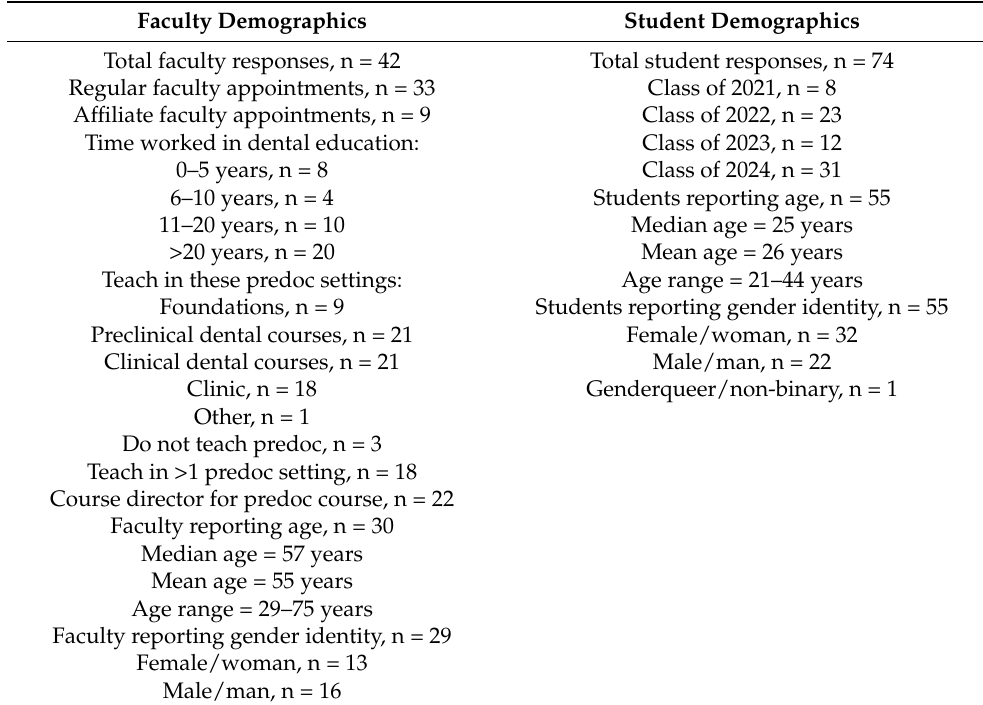
Table 2. Demographics of electronic survey responses. Age and gender identity were asked